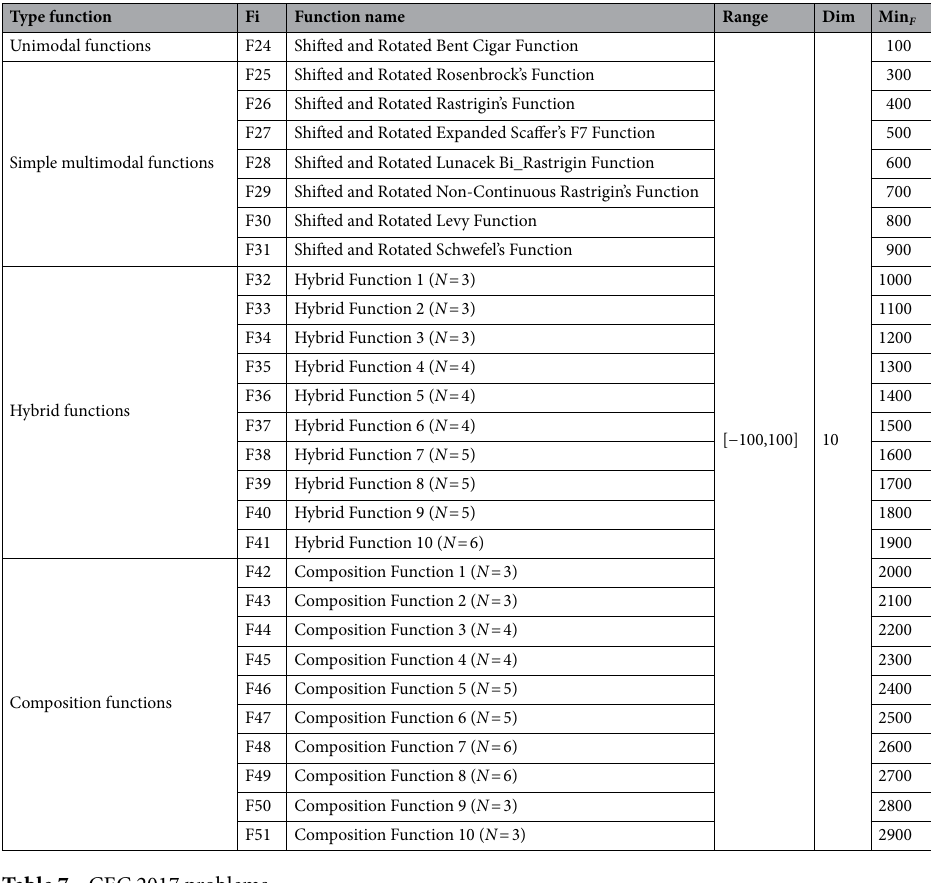
Table 7. CEC 2017